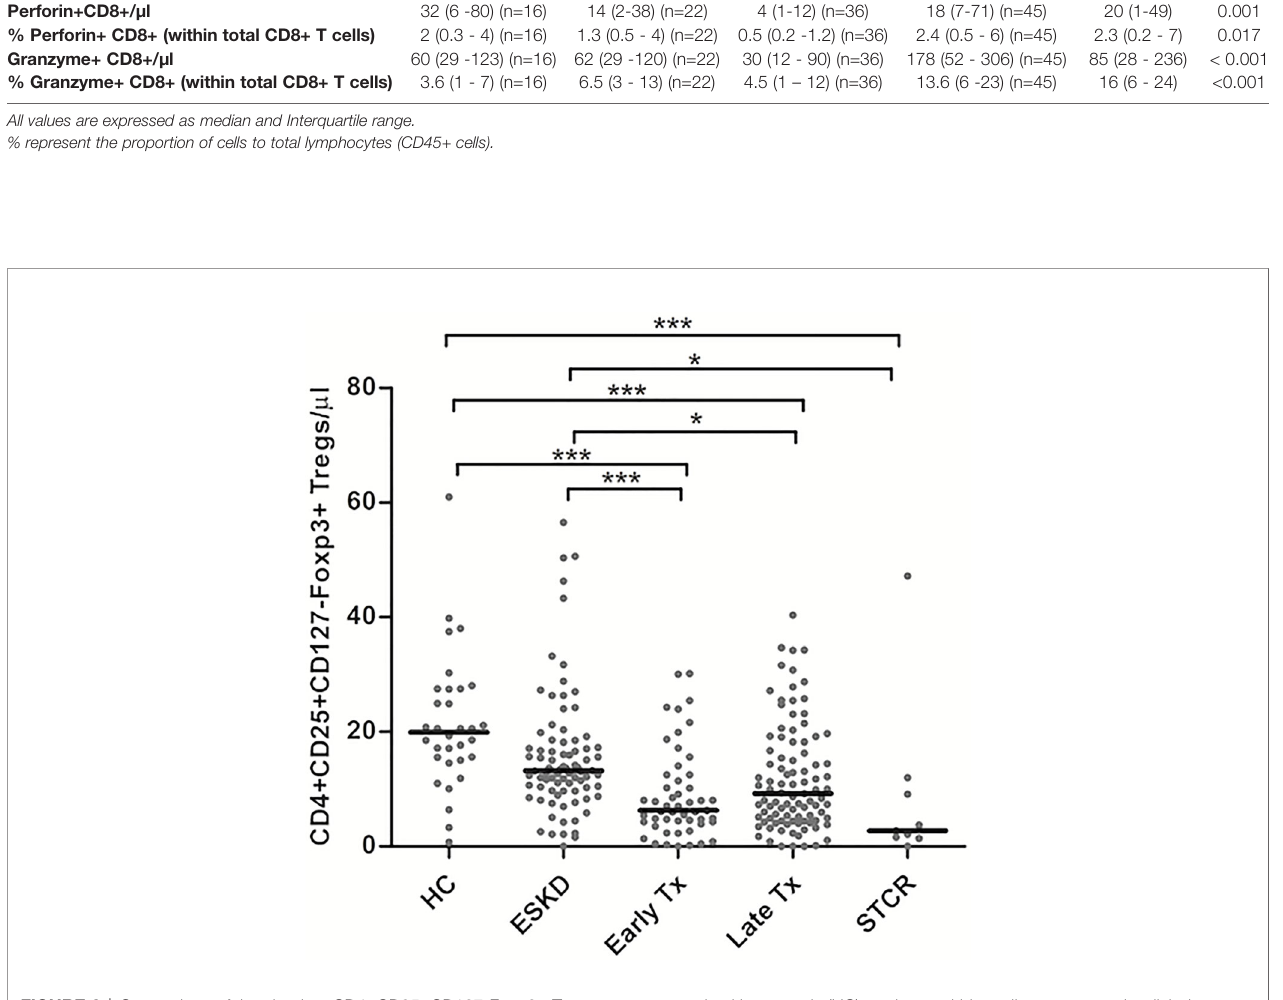
FIGURE 2 | Comparison of the absolute CD4+CD25+CD127-Foxp3+ Treg counts among healthy controls (HC), end-stage kidney disease on regular dialysis (ESKD), early and late transplant recipients (Tx), and transplant recipients with a steroid-treated acute rejection (STCR): Medians were compared among the groups with Kruskal-Wallis test and p-values were adjusted after correction for multiple comparisons, *p < 0.05, ***p <